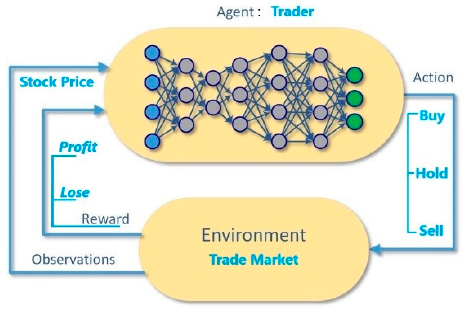
Figure 5. Deep reinforcement learning structure for cryptocurrency trading.